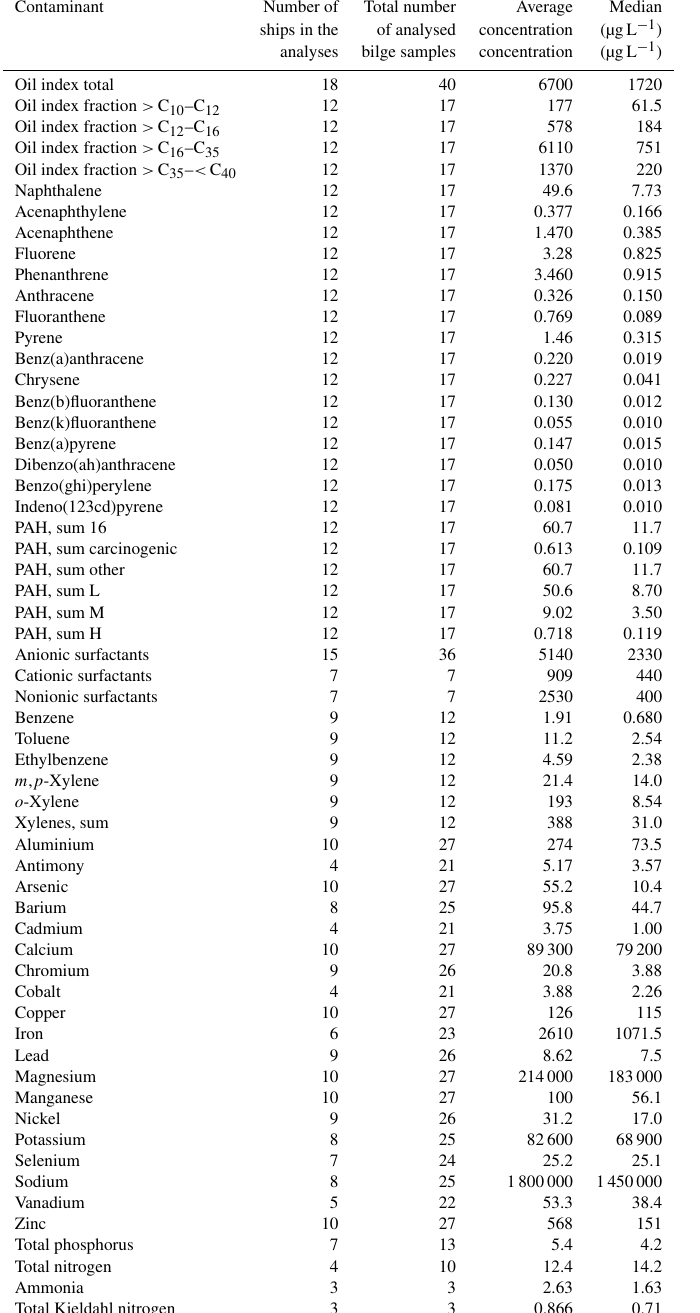
Table A1. Concentration of contaminants and nutrients in bilge water. The complete dataset and references are presented in the Supplement. Contaminant Number